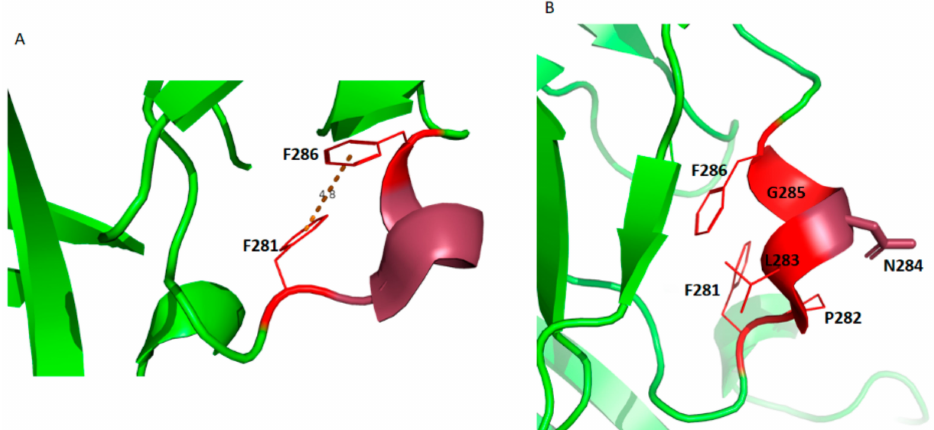
Figure 8. The mVP40 CTD hydrophobic loop may provide an interface for self-assembly or host protein interactions. ( A ) The two Phe residues present in the loop may form a T-shaped hydrophobic stacking interaction that may stabilize the loop’s orientation. The average distance between the aromatic rings of the two Phe residues is 4.8 Å. ( B ) Based on the outward orientation of the side chain of Asn 284 , it is possible that Asn 284 participates in key interactions (H-bonding) with a host protein or is involved in